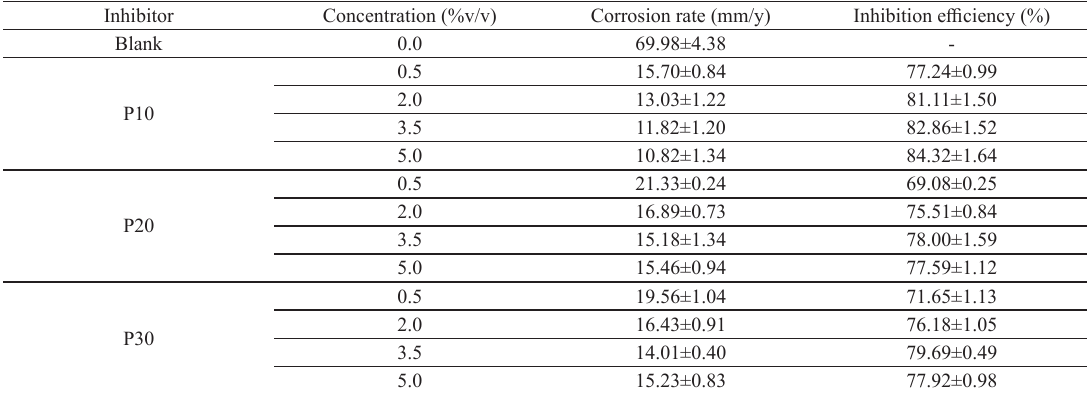
Table 2. Weight loss data for P10, P20 and P30 in HCl 1M at 333 K.